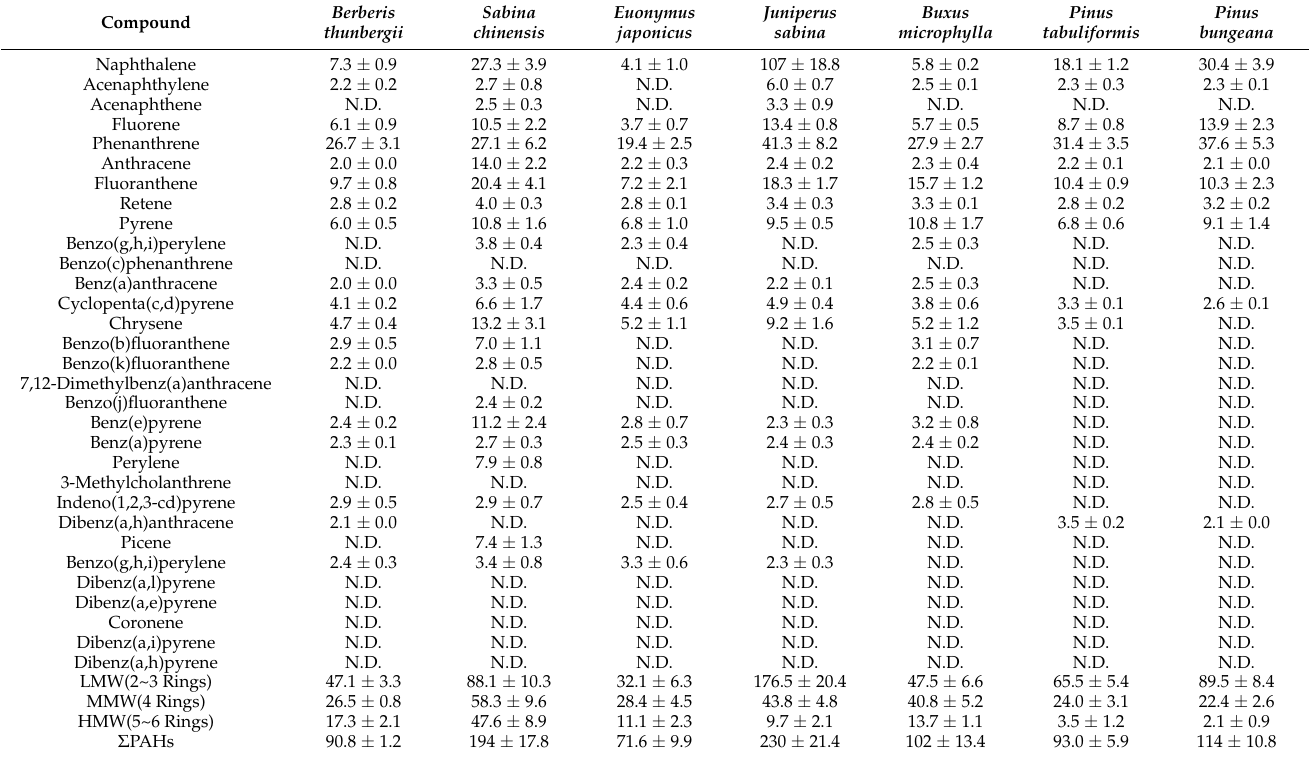
Table 4. Concentration (average ± SD) of PAHs in different plant leaves